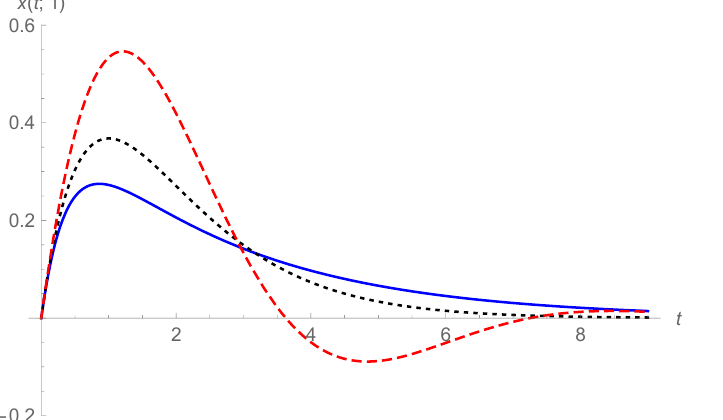
Figure 4. Curves of x ( t ; α = 1 ) for m = k = 1 and c = 3 (solid line), c = 2 (dotted line), and c = 1 (dashed